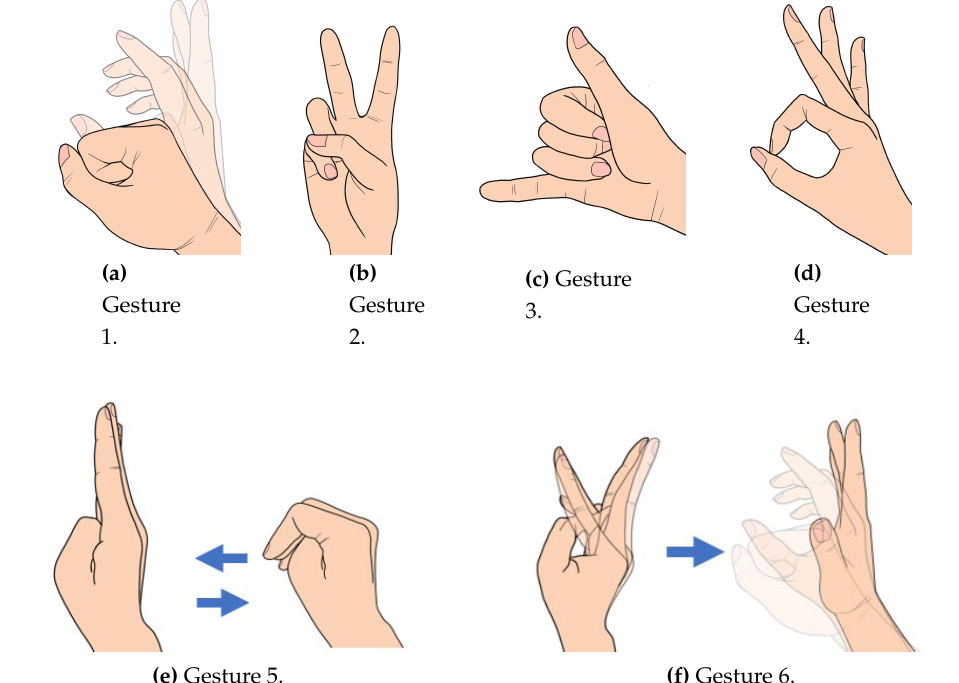
Figure 12. Hand gestures considered for the